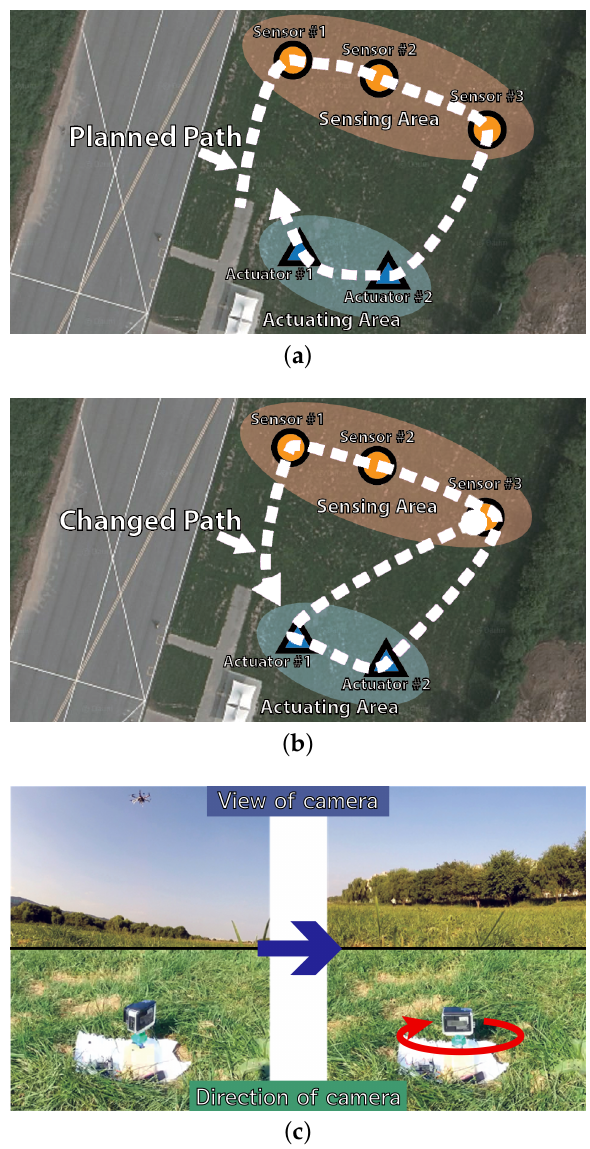
Figure 10. The pictures of the demonstration scenario including path change information. ( a ) Experiment setting and expected DaaG path before the experiment begins. ( b ) Path change due to the retrieved data. ( c ) Actuator changed by DaaG